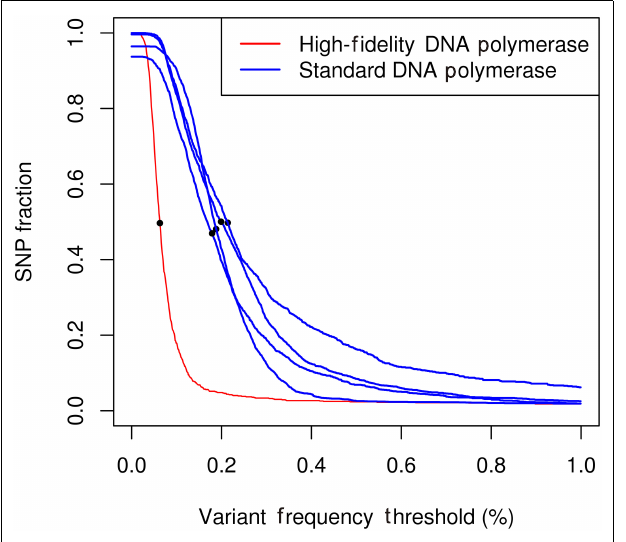
FIGURE 3 | Number of called SNP per nucleotide as a function of the frequency set as the threshold for the five genes studied in the experiment. The dots represent the frequency threshold at which the proportion of bases identified as polymorphic is 50% of the maximum value. Blue lines represent amplicons sequenced using a standard polymerase. Red line represents amplicons sequenced using a high-fidelity polymerase.